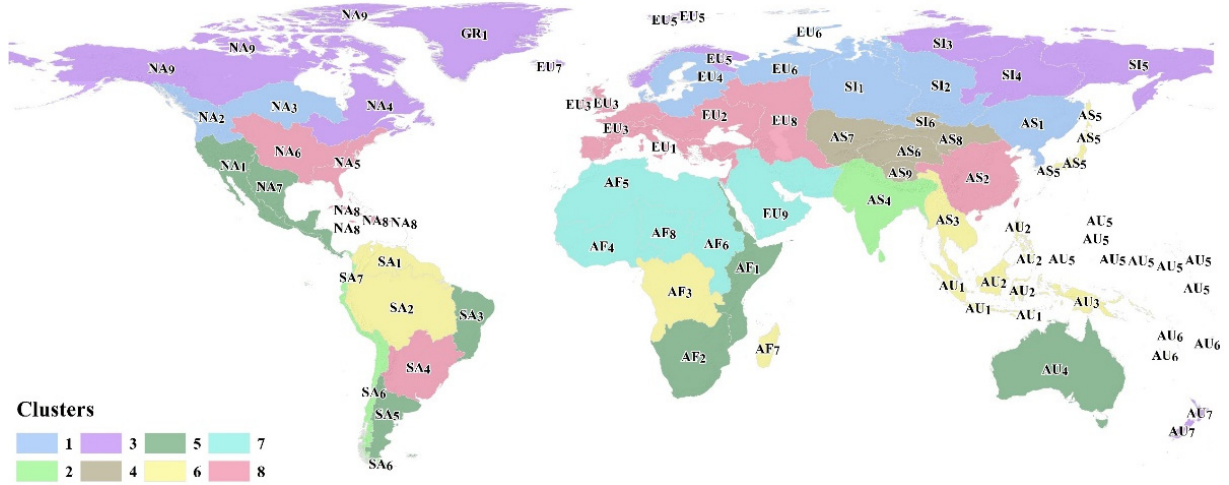
Figure 5. Result of the cluster exercise for the macro-areas in WaterProof .